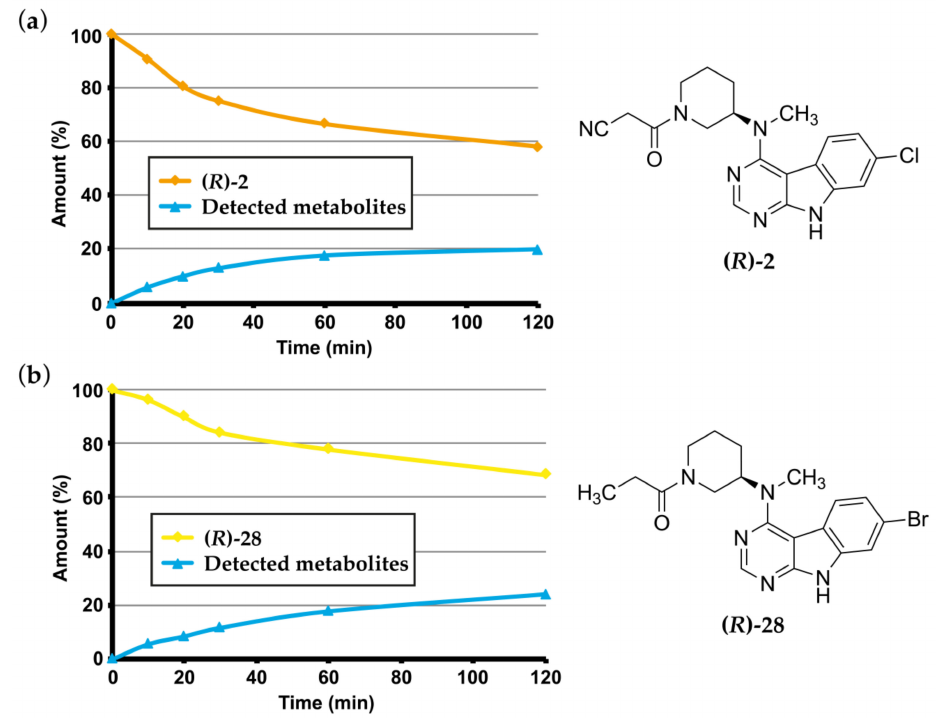
Figure 3. Microsomal degradation and formation of detected metabolites of ( a ) (R) -2 and ( b ) (R) -28 during the incubation time of 120